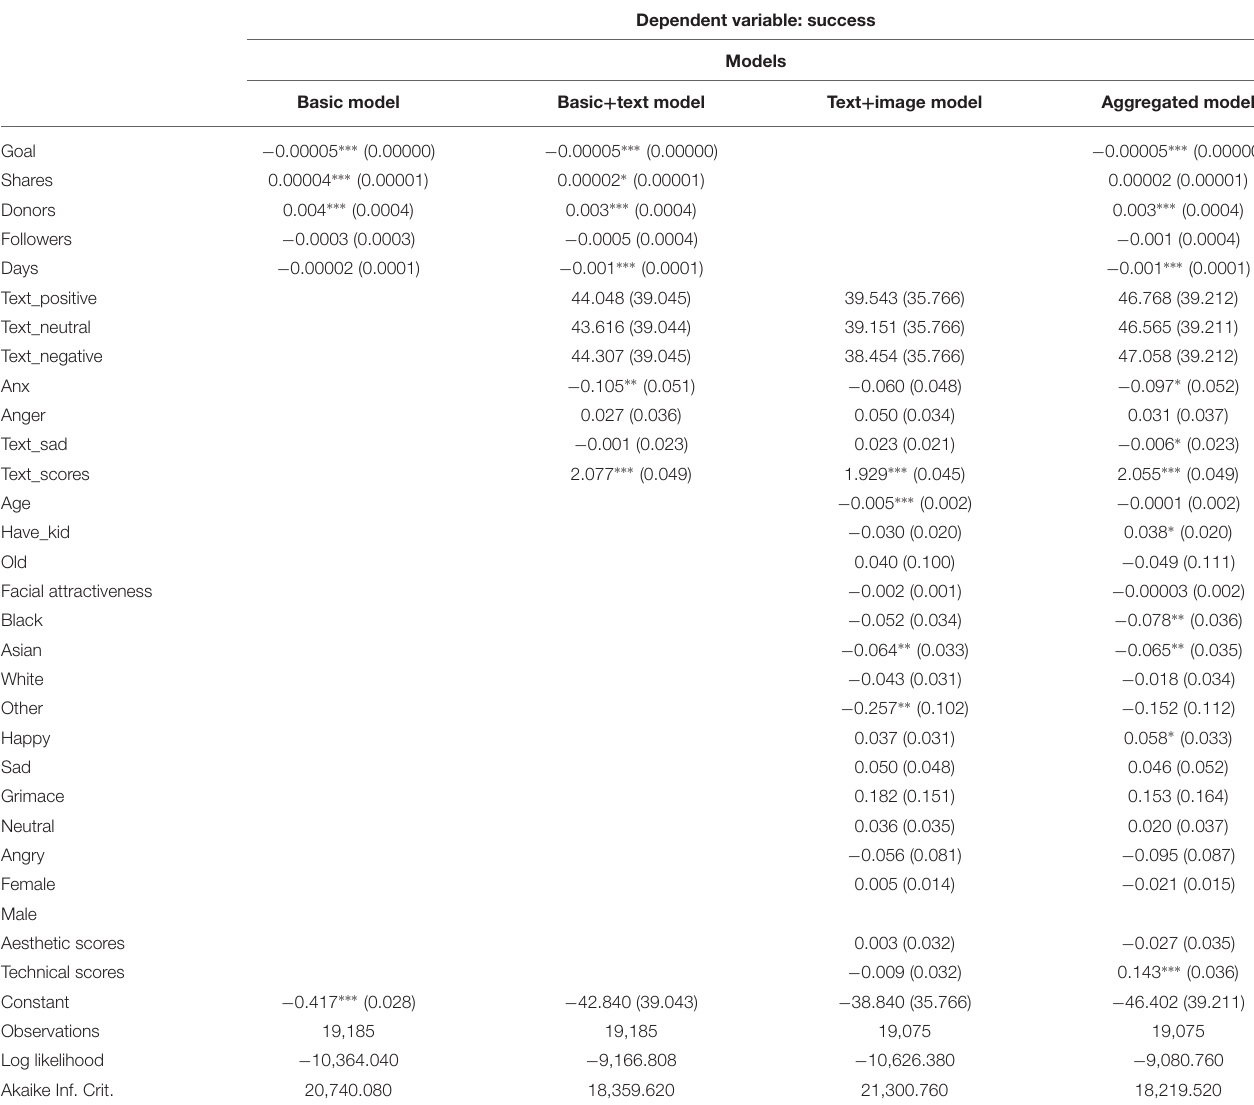
TABLE 4 | Logistic regression model results for the relationship between campaigns’ features and